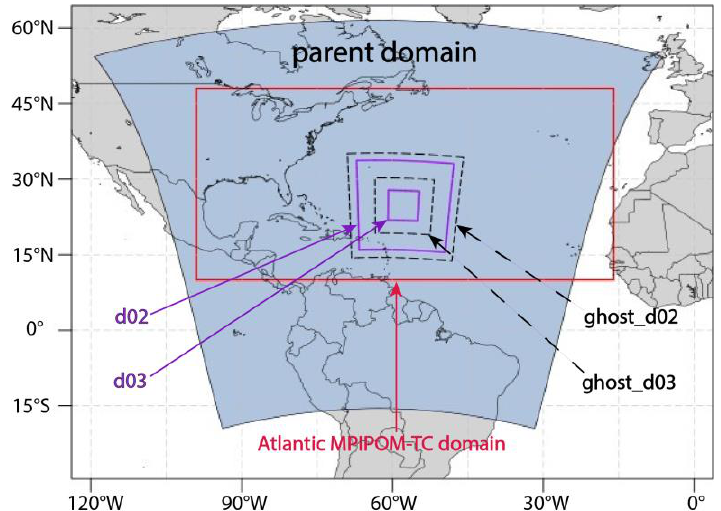
Figure 2. The HWRF model forecast domains are indicated by the 13.5 km parent domain (d01, blue region) and two nested vortex-following domains (d02 and d03, 4.5 and 1.5 km, and purple solid boxes), while the HWRF data assimilation domains are depicted by the ghost domains (ghost-d02 and ghost-d03, black dashed lines). The unified Atlantic Message Passing Interface Princeton Ocean Model for Tropical Cyclone (MPIPOM-TC) domain is denoted by the red box.